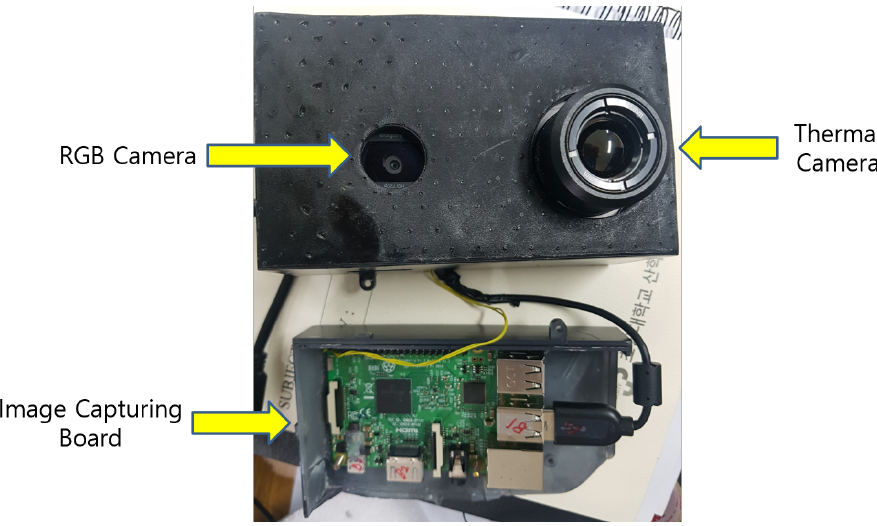
Figure 4. Physical structure of dual camera device and image capturing